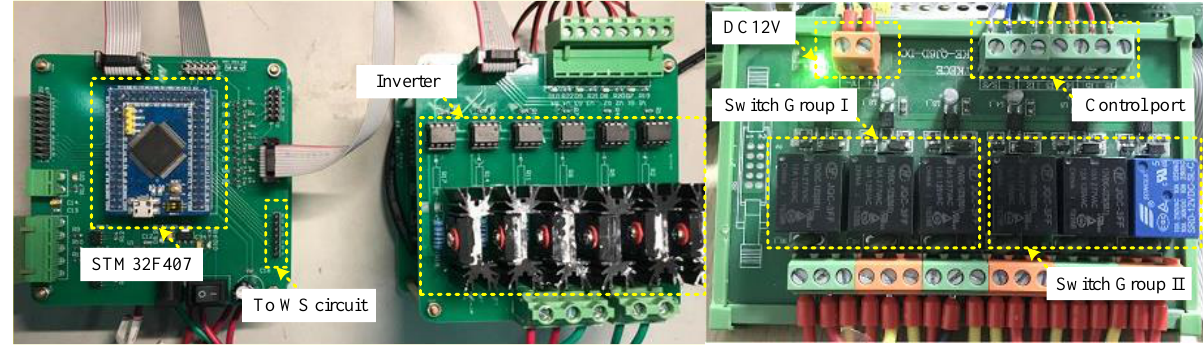
Figure 8. The controller of the investigated DS-PMM using WS strategy.